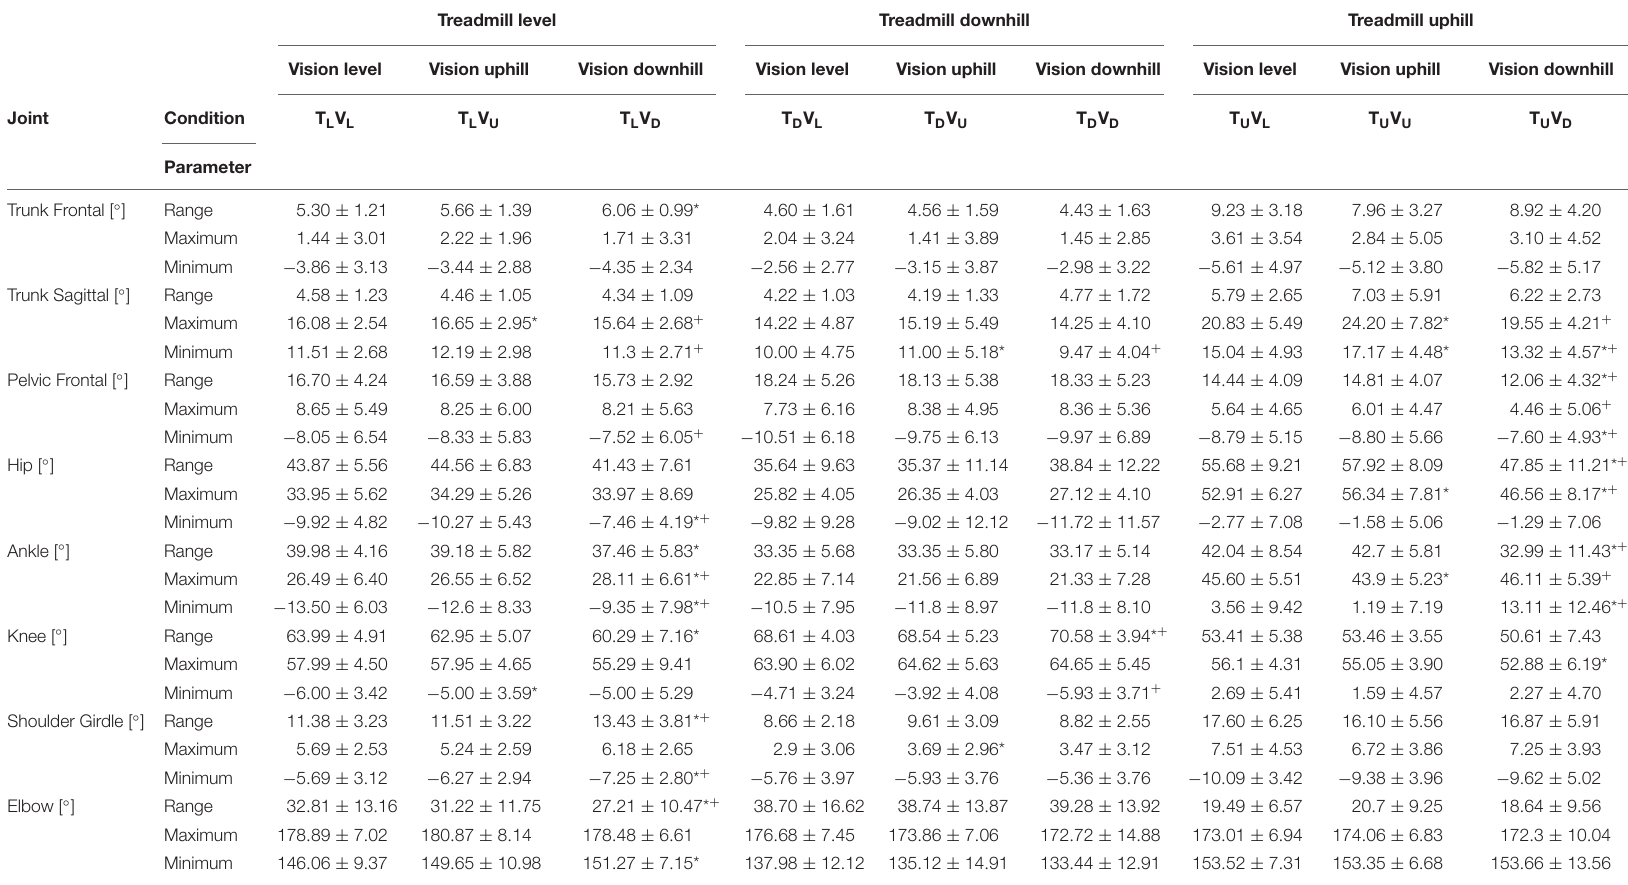
TABLE 1 | Postural